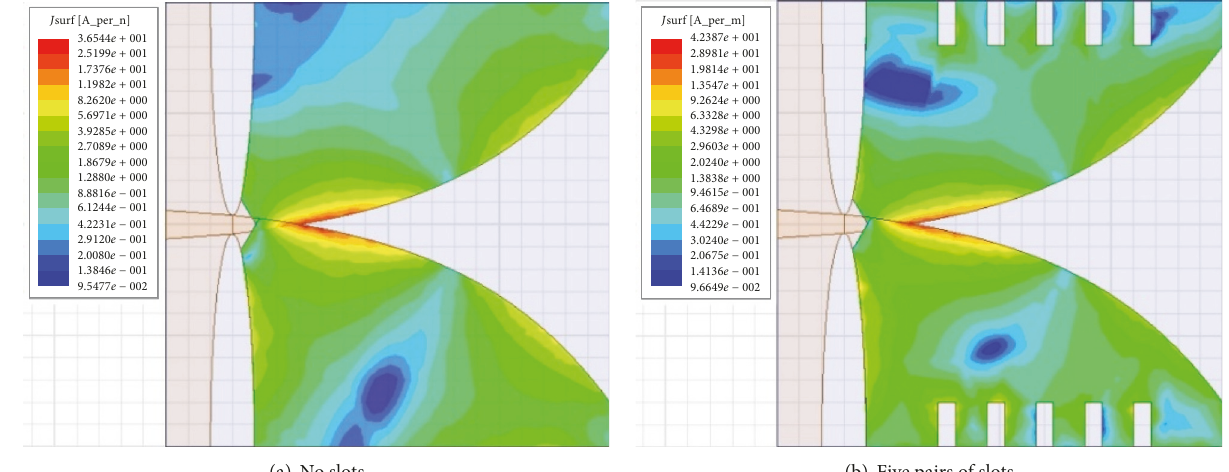
Figure 5: Surface current distribution.